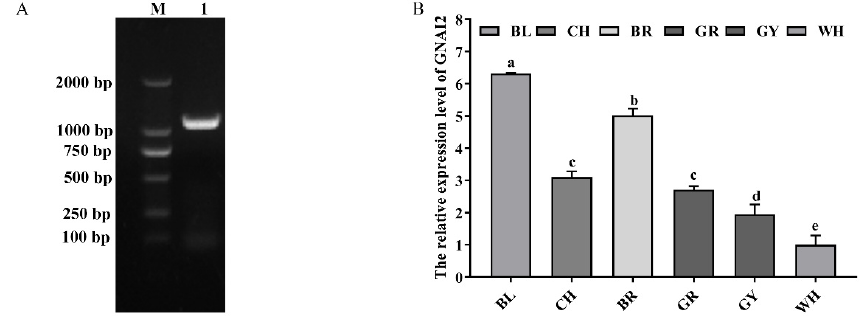
Figure 1. The expression levels of GNAI2 in the skin of rabbits of different coat colors: ( A ) the 160 rabbit GNAI2 cDNA was successfully cloned. M, DL2000 DNA marker; lane 1, the coding 161 sequence (CDS) of GNAI2; ( B ) the GNAI2 mRNA levels in the skin of rabbits of different coat 162 colors were determined. Samples were in triplicates and the relative expression levels of the genes